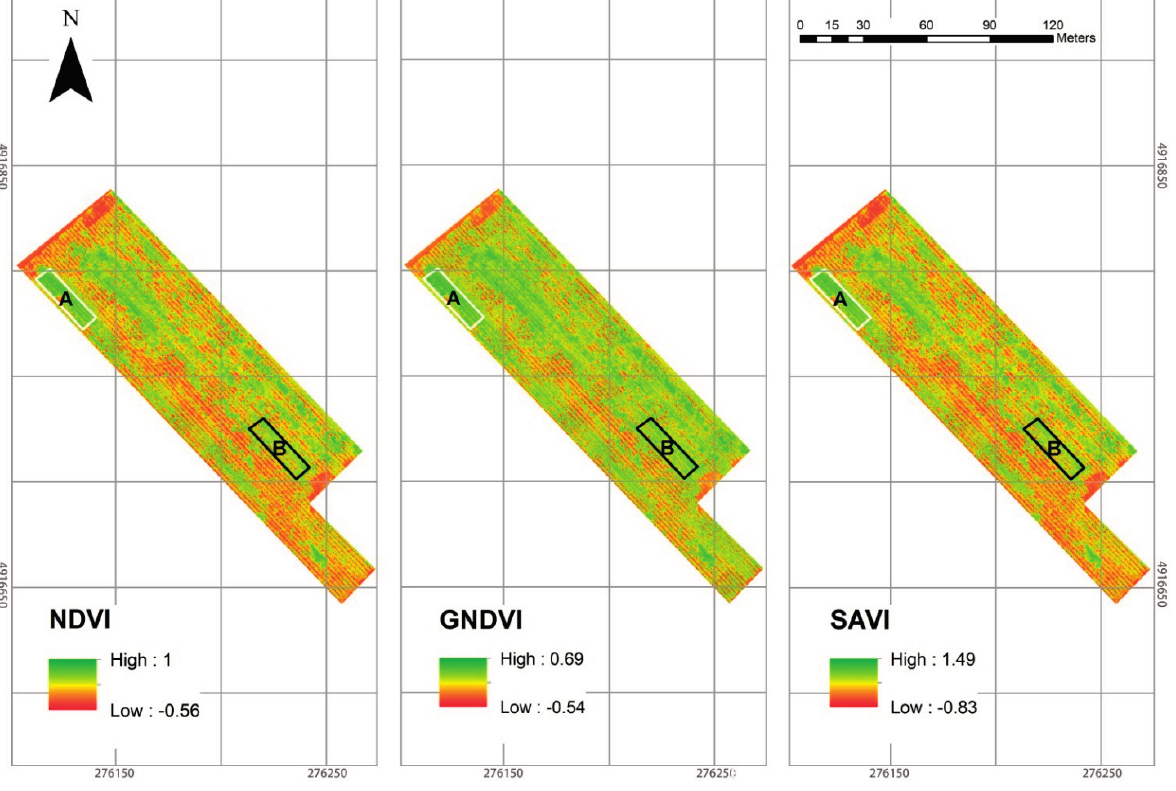
Figure 12. The NDVI, GNDVI, and SAVI (L = 0.5) maps for the tomato crop. Areas A and B show zones with high and low VI values, respectively.